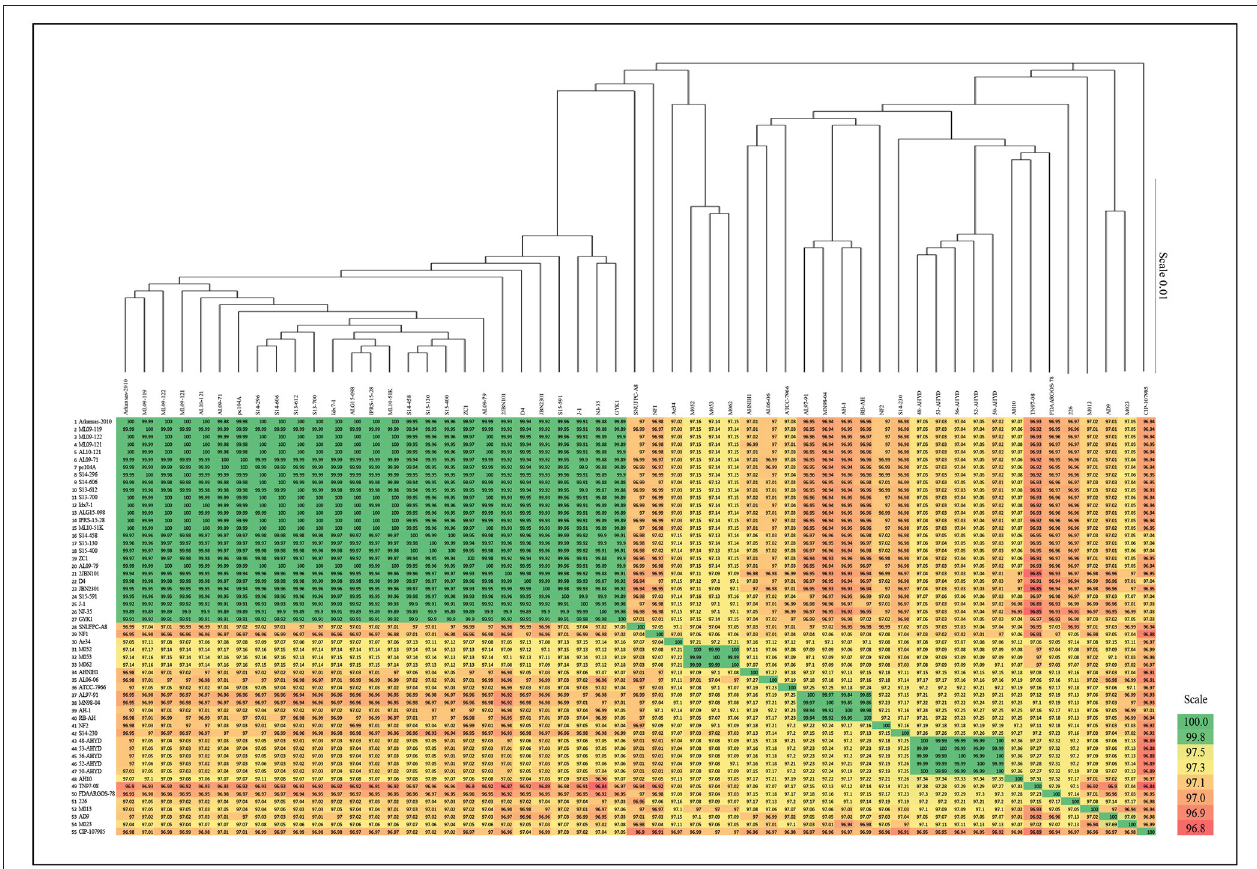
FIGURE 1 | Average nucleotide identities (ANI) of A. hydrophila genomes and phylogenetic tree based on core genome. Note that branch lengths of the phylogenetic tree were reduced to fit the